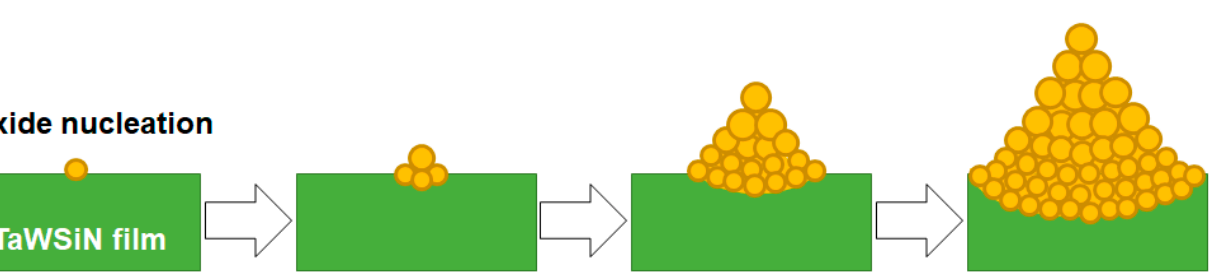
Figure 16. Schematic of the oxidation behavior of TaWSiN films annealed at 600 °C in 1% O 2 –Ar.